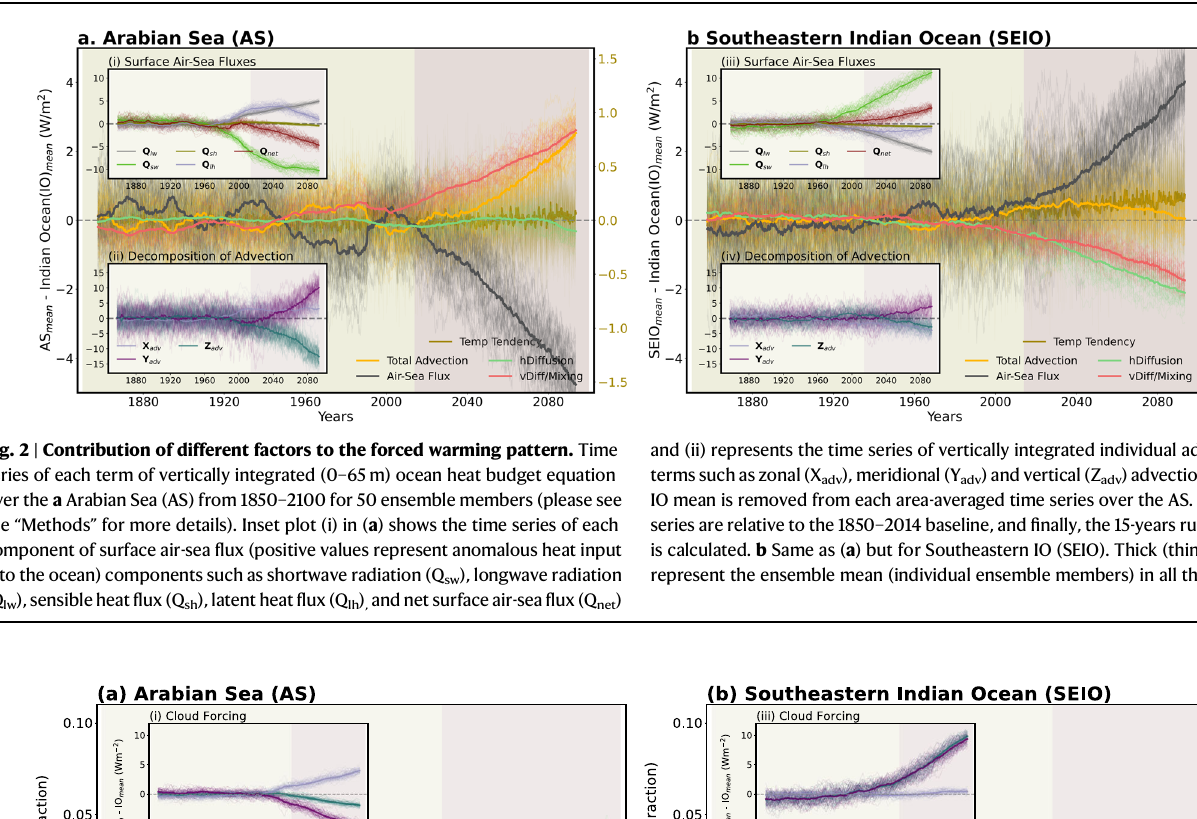
from the surface to 300hPa. Note that IO mean is removed from each area- averaged time series over the AS. All the time series are relative to the 1850 – 2014 baseline, and fi nally, the 15-years running mean is calculated. b Same as ( a ) but for SEIO. Thick (thin) lines represent the ensemble mean (individual ensemble mem- bers) in all the plots.